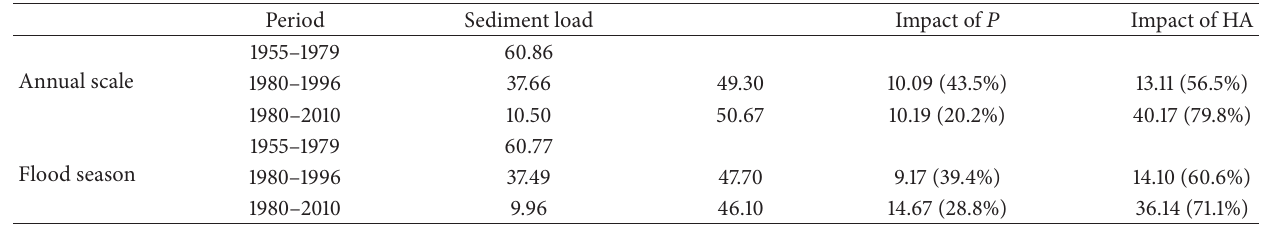
Table 4: Impacts of precipitation ( 𝑃 ) and human activities (HA) on changes of sediment load (10 6 t).